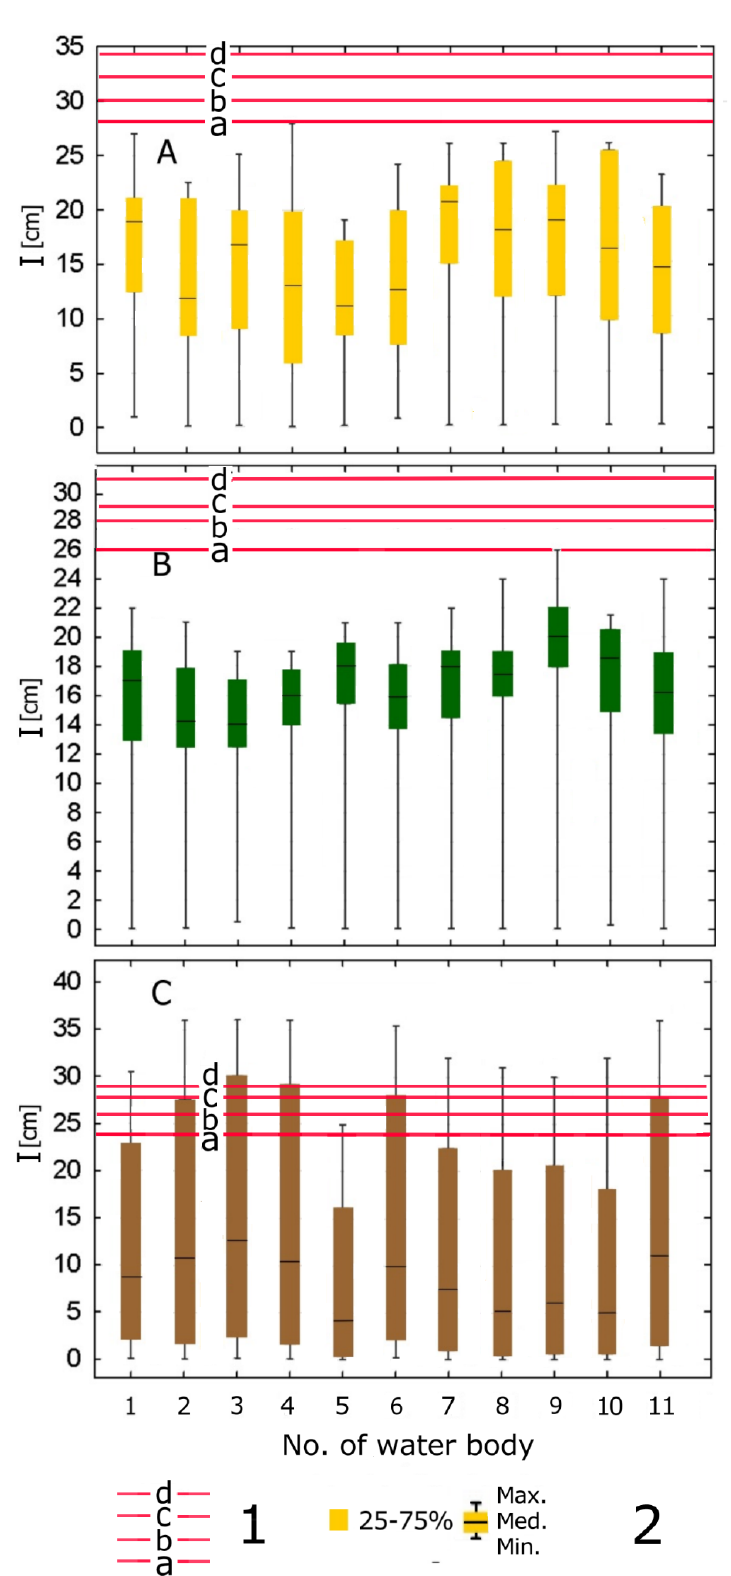
Figure 4. Ice thickness on the water bodies of the Silesian Upland in the ( A ) first, ( B ) second, and ( C ) third winter season: I—ice thickness; No. of water body—ordinal number (numbering as in Table 3). 1—the maximum ice thickness values obtained from modelling using Stefan’s